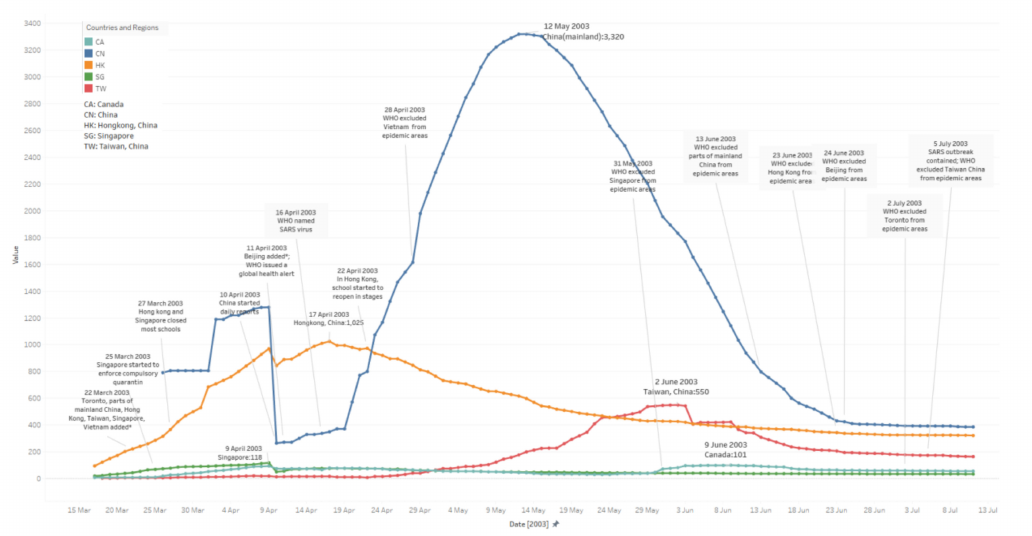
Figure 1. Daily existing infected case number trends of five countries and regions. (17 March–11